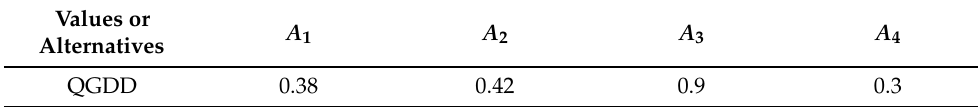
Table 1. Mean QGDD of each of the alternatives. Values or